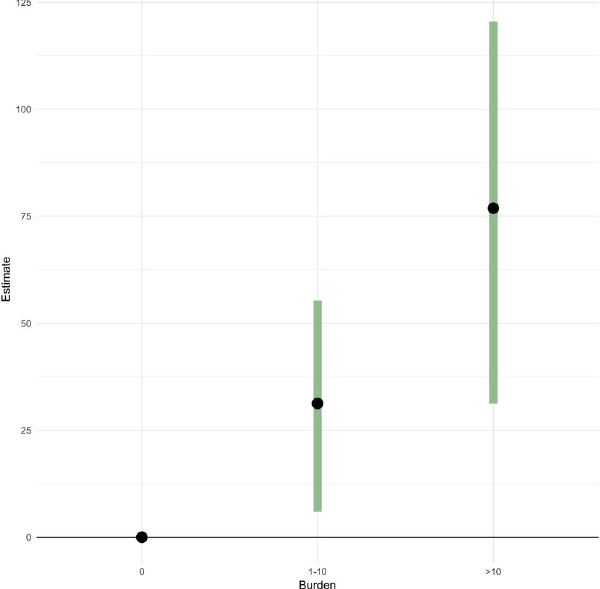
Figure 7. Point estimates and 95% Confidence Intervals for animals with different levels of burden compared to animals with 0 burden. Figure shows the estimated increase in slaughter age in days for an animal with 345 kg carcass weight for burden categories 1–10 and > 10 compared to a burden of 0, as estimated by the burden